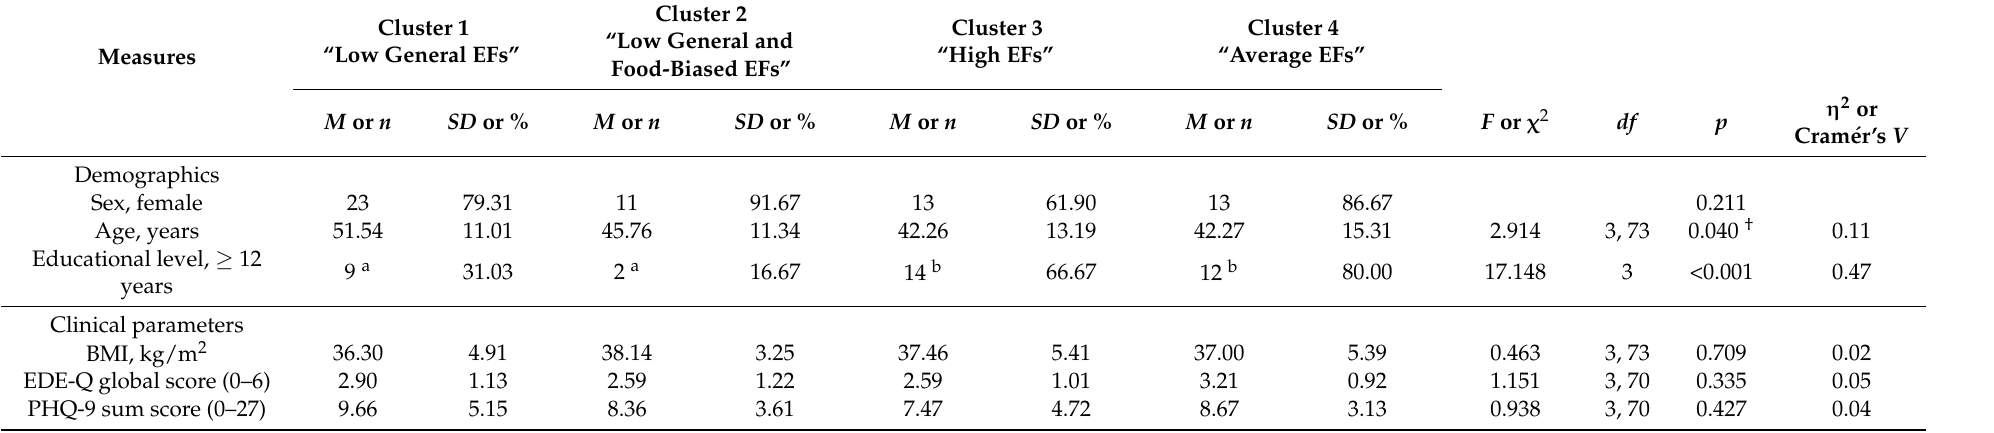
Table 4. Demographic and clinical characteristics of clusters according to their executive functions